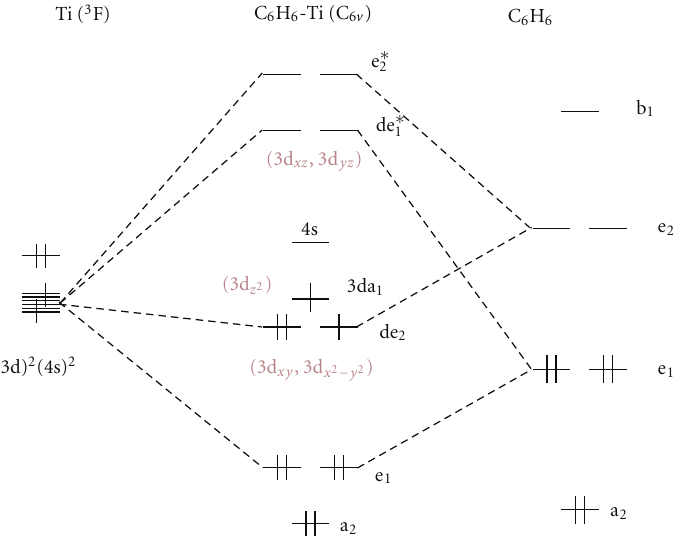
Figure 1: Orbital interaction diagram of the C 6 H 6 Ti -C 6 v configuration.